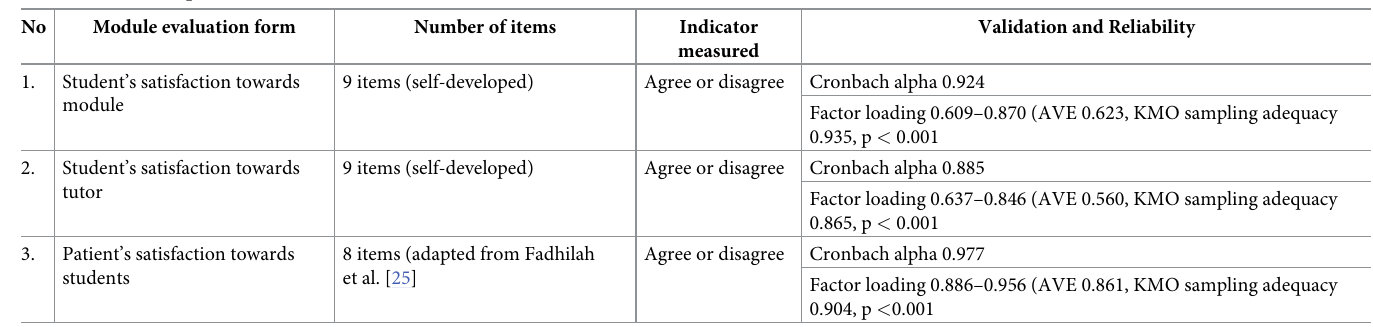
Table 3. Module implementation evaluation